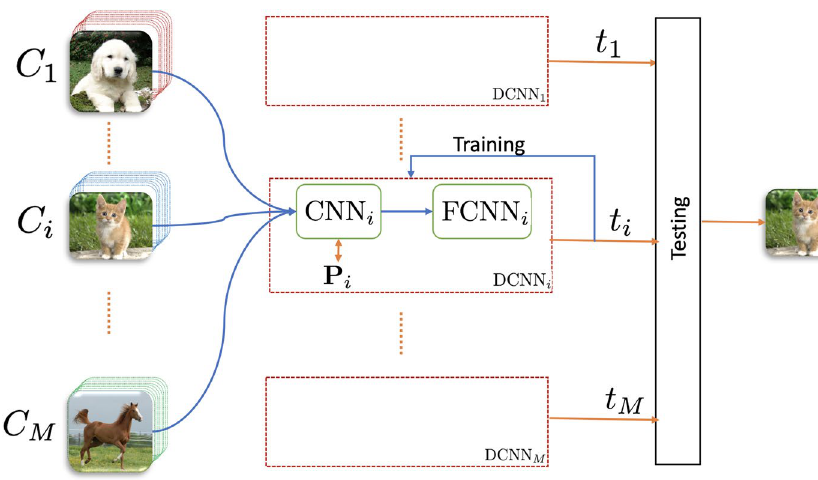
Fig. 1 System architecture for first